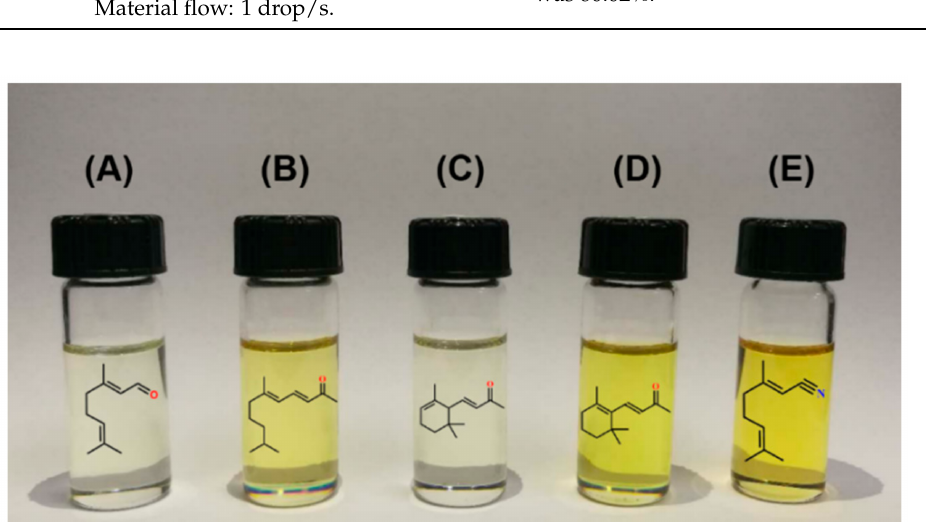
Figure 2. Citral-derived fragrances from Litsea cubeba (LC) essential oils: ( A ) purified LC essential oils; ( B ) pseudoionone; ( C ) α -ionone; ( D ) β -ionone; ( E ) lemonile. Ionone is an oily liquid with color ranging from colorless to slightly yellow and a strong violet floral aroma. It is an indispensable raw material or intermediate in the aromatization, in which synthesized products can be divided into α -ionone, β -ionone, and uncommon γ -ionone. α -ionone is often used for the formulation of perfume, and β -ionone can be used for the synthesis of vitamin A. Citral was used to undergo aldol condensation with acetone under the catalysis of NaOH to form pseudoionone, which was then cyclized to produce ionone catalyzed by phosphoric acid with a total yield